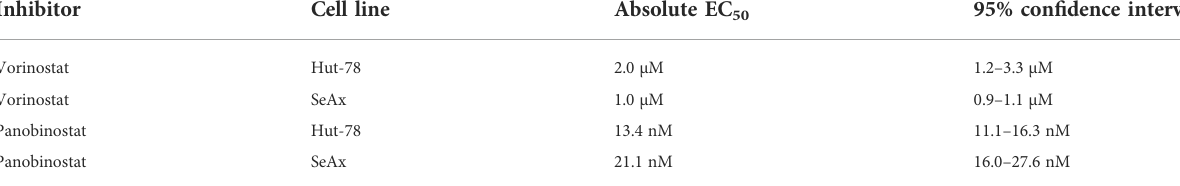
TABLE 1 EC 50 values for HDAC inhibitors. Inhibitor Cell